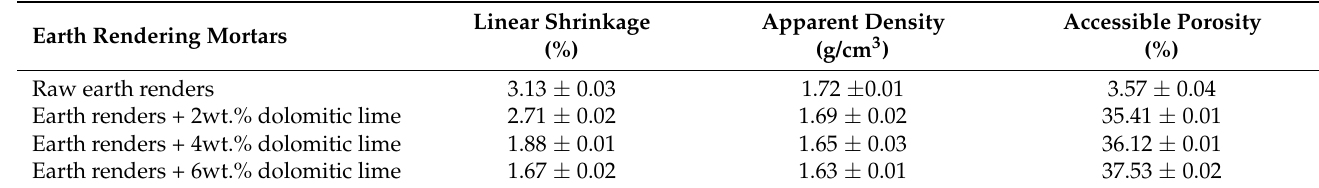
Table 3. Physical properties of earth renders amended with dolomitic